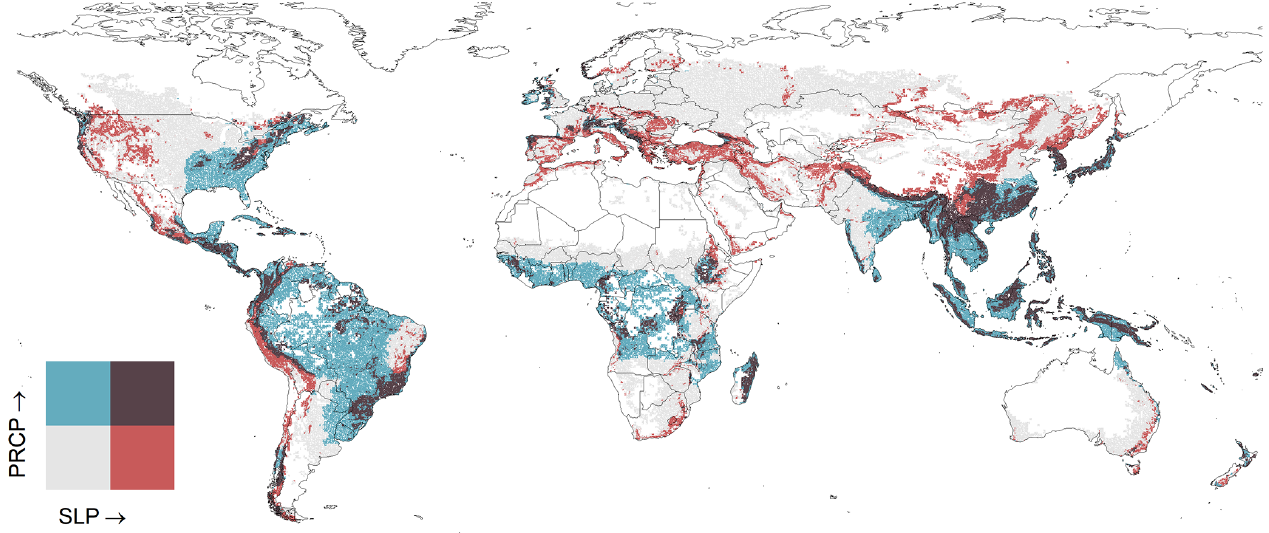
Figure 7. Distribution of low-to-high slope steepness (SLP) and annual precipitation (PRCP) in maize and wheat fields. Dark areas illustrate grid cells where dominant slopes are steeper than 8% and annual precipitation is above 1000mm. Correspondingly, blue, red and grey pixels are below one or both thresholds.